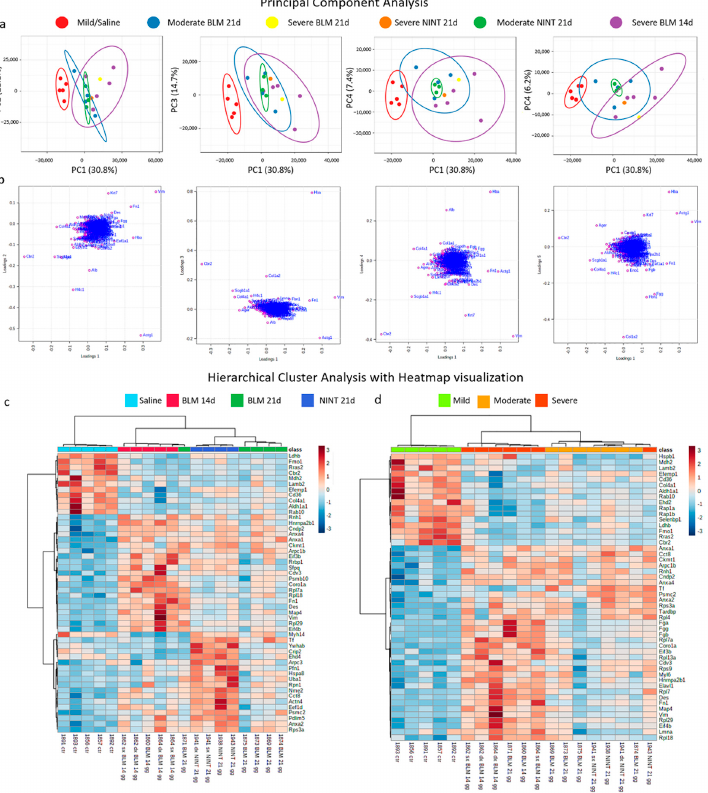
Figure 3. Multivariate Analysis. Principal Component Analysis (PCA): ( a ) 2D score plot between the following PCs, left ‐ to ‐ right: PC1 ‐ PC2, PC1 ‐ PC3, PC1 ‐ PC4, and PC1 ‐ PC5. The explained variances are shown in brackets. Pareto scaling is applied to rows, and singular value decomposition (SVD) with imputation is used to calculate principal components. Prediction ellipses are such that, with a probability of 0.95, a new observation from the same group will fall inside the ellipse. n = 19 data points; 2D score plots were created with Clustvis. ( b ) Loadings plots; loading plots were created with MetaboAnalyst 5.0. Hierarchical cluster analysis (HCA) with heatmap visualization based on ( c ) sample treatment and ( d ) the average histological grade. Heatmaps were created with MetaboAnalyst 5.0. The data were autoscaled; Pearson was used as a distance measure, and Ward as a clustering method. Heatmaps showed the top 50 features selected by t ‐ test/analysis of variance (ANOVA). BLM—bleomycin; NINT—nintedanib; and d—days. 2.2. Pulmonary Fibrosis Progression in Bleomycin ‐ Treated Mice: Mild, Moderate, and Severe Based on the results of the multivariate data analysis and with the aim of investigating the proteomic alterations involved in fibrosis progression, samples were stratified based on the severity of their fibrosis grade. For this purpose, only saline samples and bleomycin ‐ treated samples were investigated, while all nintedanib ‐ treated samples were excluded from this step.